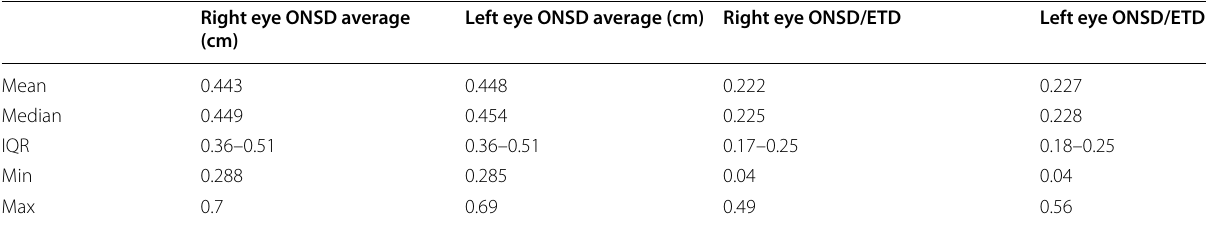
Table 2 Optic nerve sheath diameter (ONSD) and optic nerve sheath diameter/ transverse diameter of the eyeball (ONSD/ ETD) Right eye ONSD average Left eye ONSD average (cm) Right eye ONSD/ETD (cm)